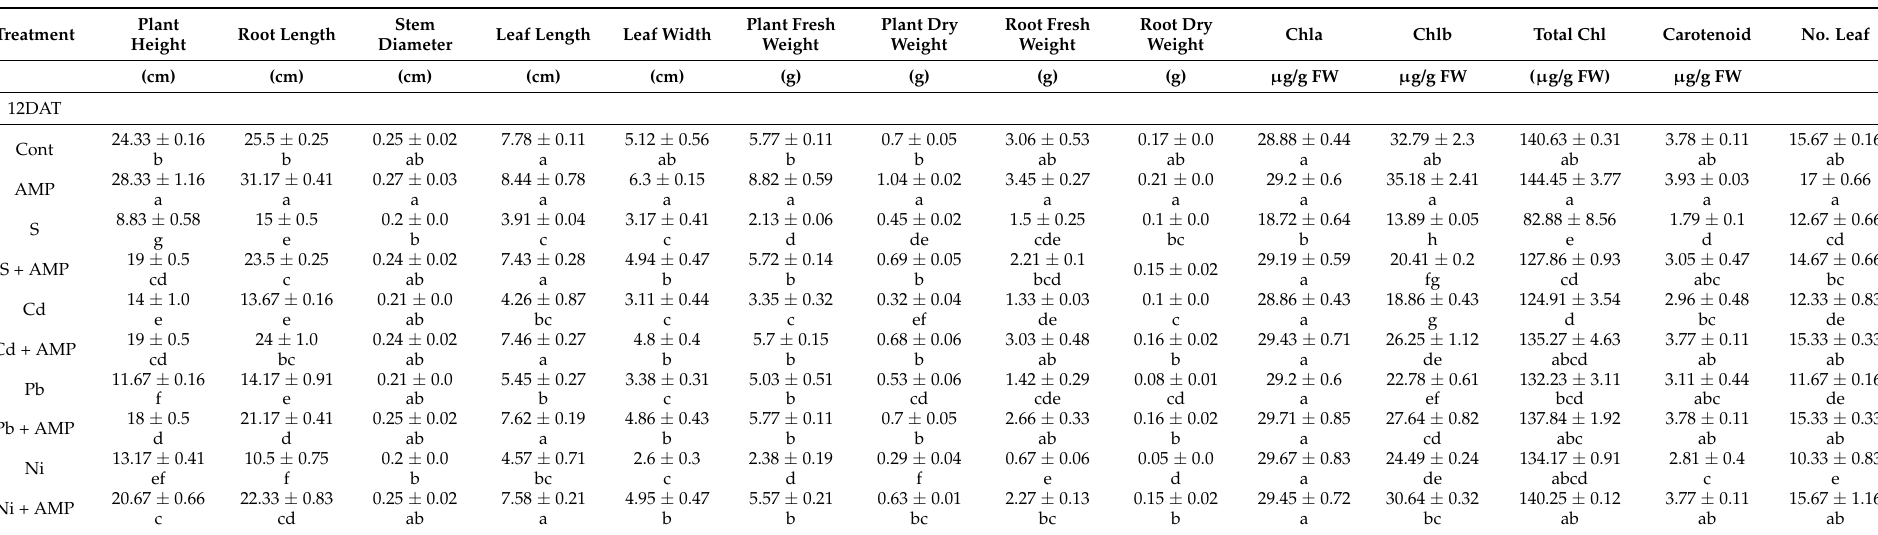
Table 1. Effect of ampelopsin application on soybean plant growth, chlorophyll a (Chla), chlorophyll b (Chlb), total chlorophyll (total Chl), and carotenoid contents under normal and stress conditions after 12 days of treatment